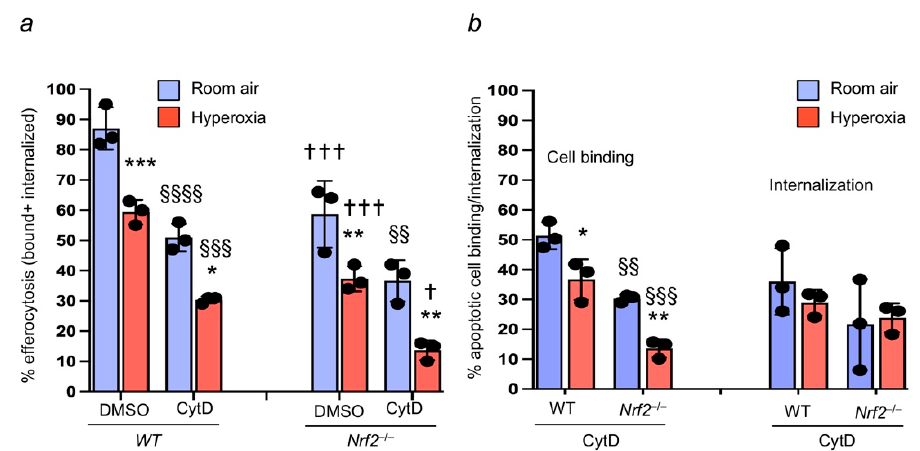
Figure 4. Nrf2 regulates apoptotic neutrophil binding to the macrophages. Nrf2 +/+ (WT) and Nrf2 − / − BMDM φ s were exposed to room air or hyperoxia and then incubated with cytochalasin D (CtyD) be- fore adding the labeled apoptotic neutrophils. Efferocytosis was quantified. ( a ) Both bound/attached and internalized apoptotic cells in the presence and absence of CytD were enumerated, and data are represented % efferocytosis. * hyperoxia versus room air of respective genotypes, †, Nrf2 − / − versus WT counterparts; § DMSO versus CtyD of respective genotypes. */† p < 0.05; **/§§ p < 0.01; ***/†††/§§§ p < 0.001; §§§§ p < 0.0001. Blue, room air group; Red, hyperoxia group. ( b ) Both bound and internalized apoptotic cells were enumerated by comparing values of respective CytD (bound) and DMSO-treated (bound and internalized) samples, * Hyperoxia versus room air of respective genotypes, and §, Nrf2 − / − versus WT versus counterparts. Values are from three independent samples. * p < 0.05; **/§§ p < 0.01; §§§ p < 0.001. Blue, room air group; Red, hyperoxia group.